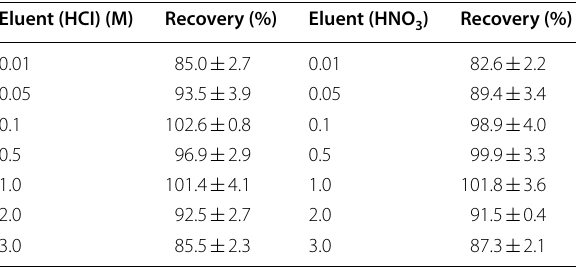
Table 1 Type and concentration of desorption solution on the Cd(II) ions’ extraction efficiency Eluent (HCI) (M) Recovery